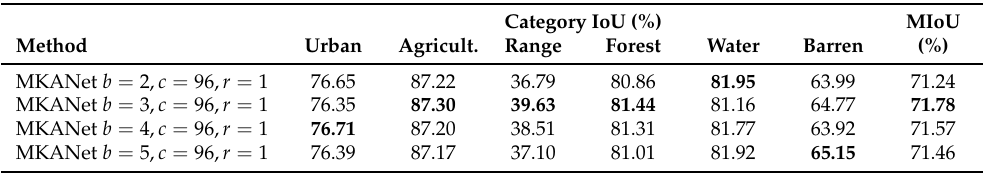
Table 11. Comparison of MKANets with a variable number of parallel branches on the DeepGlobe Land Cover